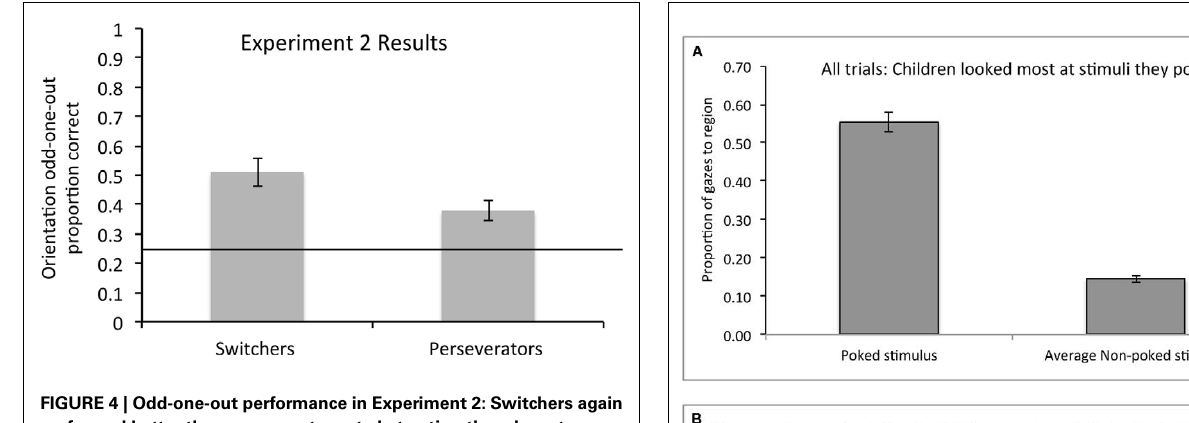
FIGURE 4 | Odd-one-out performance in Experiment 2: Switchers again performed better than perseverators at abstracting the relevant dimension, even when the orientation odd-one-out task preceded the color/shape flexibility task. Error bars represent SEM.